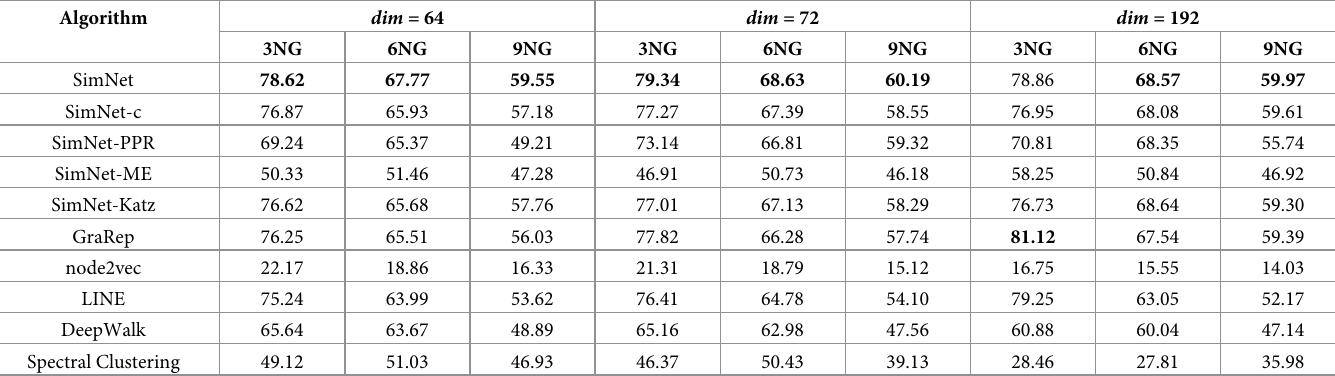
Table 3. Clustering results on 20-newsgroups (200